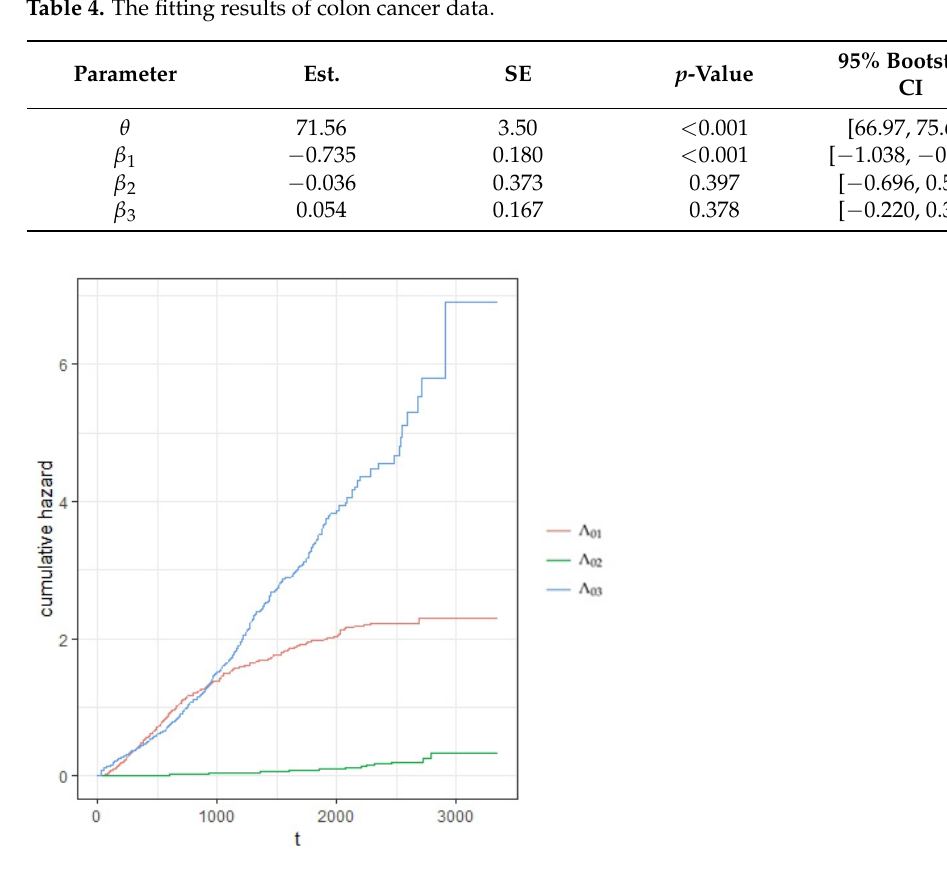
Figure 3. Cumulative hazard for different transitions in terms of